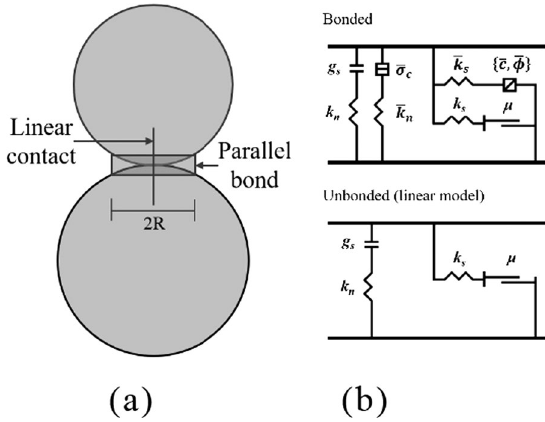
Fig. 1 Linear parallel bond model (Itasca 2016)